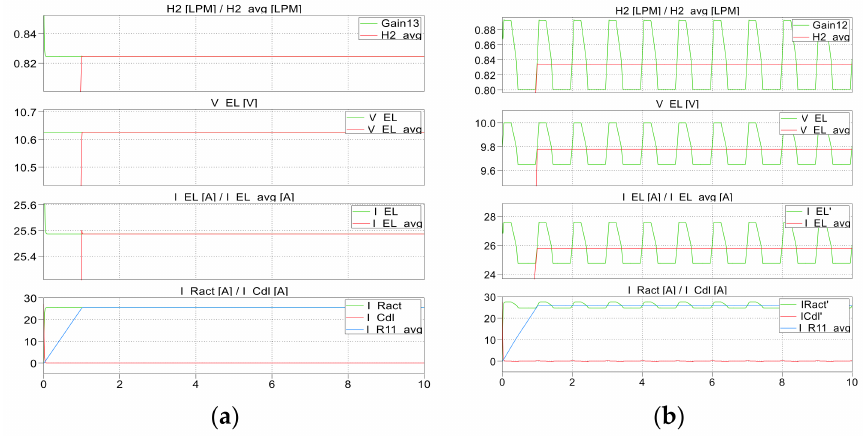
Figure 14. DC and pulsed operation simulation results: ( a ) DC, ( b ) Pulse operation.